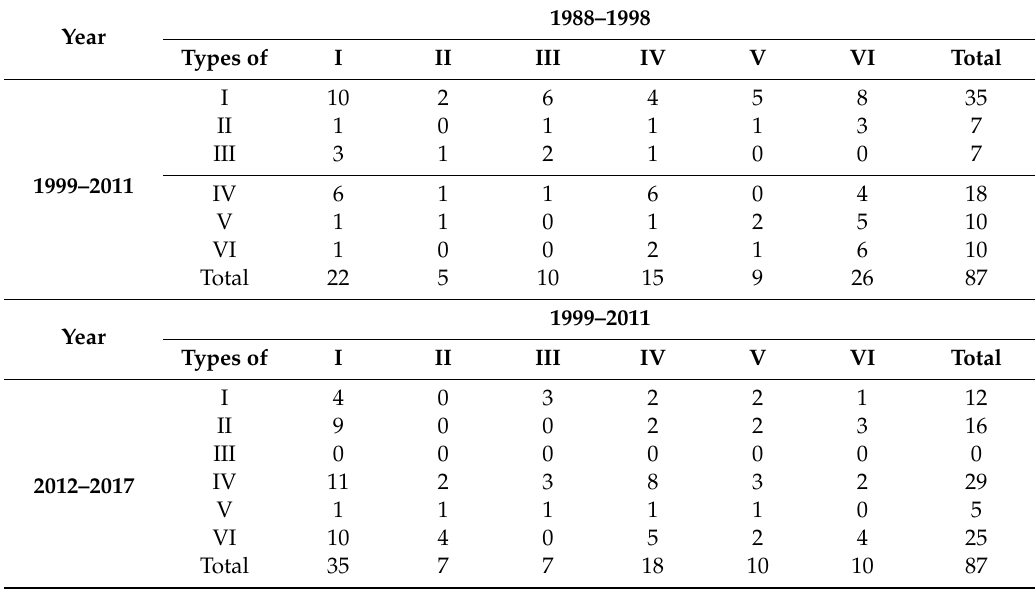
Table 4. Evolution of agricultural development types in Gansu Province from 1988 to